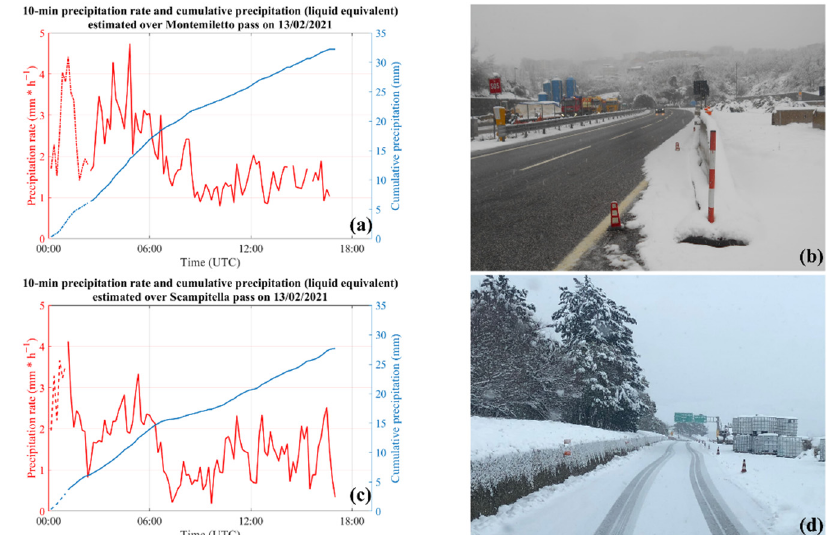
Figure 15. The left panels show the 10 min time series of the radar-based precipitation rate (in mm ∙ h − 1 , red line) and cumulative precipitation (in mm, blue line) estimated on 13 February 2021 (from 00:00 to 17:00 UTC) over the A16 highway Montemiletto ( a ) and Scampitella ( c ) passes. For both precipitation rate and cumulative precipitation, the line style indicates the precipitation type, i.e., the solid line corresponds to snow, the dashed line to mixed and the dashed and the dotted line to rain. In the right panels, photographic evidence of Montemiletto ( b ) and Scampitella ( d ) passes during the snowfall event is sketched. Both pictures are courtesy of Autostrade per l’Italia S.p.A.